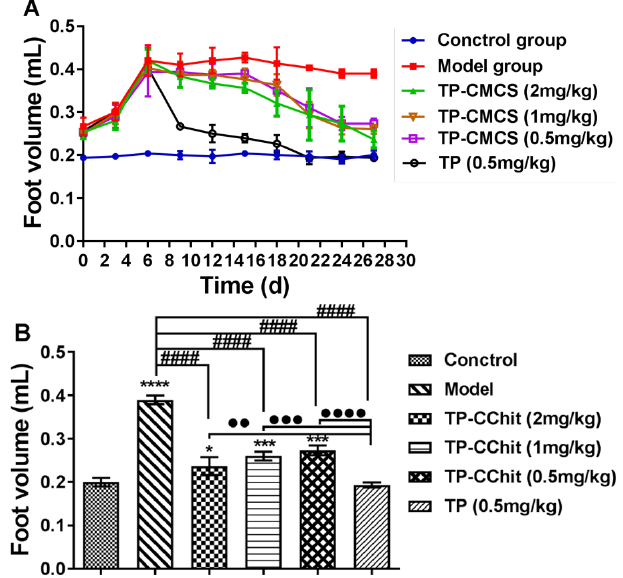
Figure 7. The changes of arthritis foot volume of the CIA mice during the process of administration for 30 days ( A ) and on the last day ( B ). * Represents p < 0.05, *** represents p < 0.001, **** represents p < 0.0001 vs. control; #### represents p < 0.0001 vs. model; •• represents p < 0.01, ••• represents p < 0.001, •••• represents p < 0.0001 vs. model.